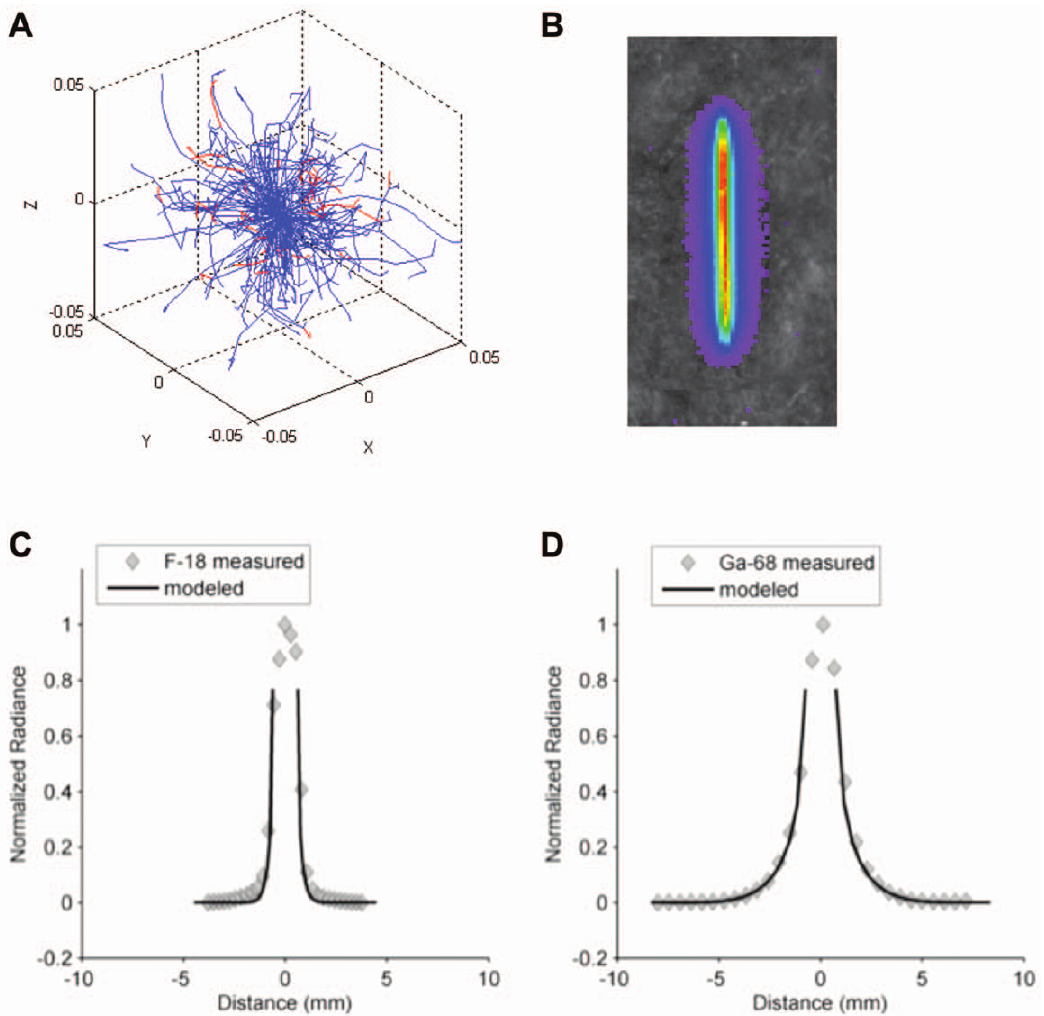
Figure 3. CR from b ’s Point Spread Functions. A) Simulated b + tracks (blue) from an F-18 point source. Red tracks are from d particles. B) A representative acquisition of the PSF experimental setup. This shows the channel in the acrylic block filled with a mixture of activity, surfactant and India ink. C) Integrated F-18 and D) Ga-68 measured radiance profiles shown as diamonds. Solid lines are modeled shapes with fitted amplitudes assuming b -particle source of